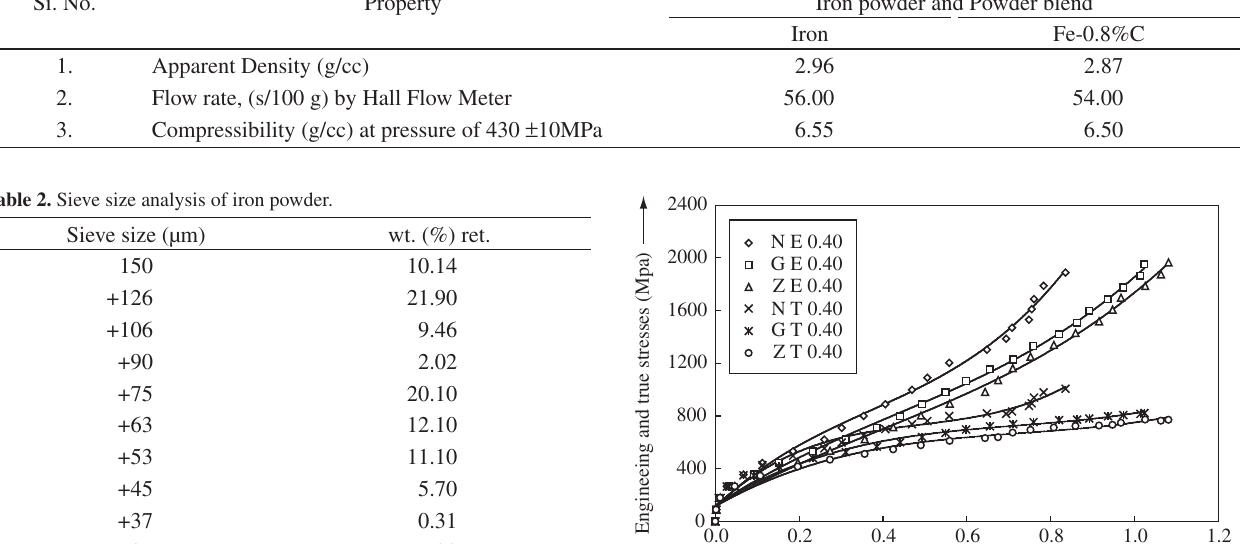
Table 1. Characterization of Iron powder and eutectoid steel blend. Si. No.